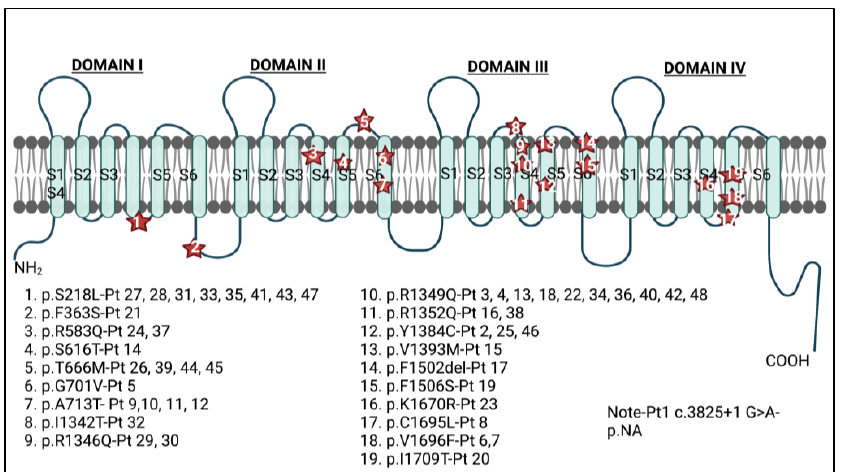
Figure 3. Schematic illustration of the Ca v 2.1 alpha1A subunit with the de novo pathogenic variants associated with SHM1 identified in this systematic review. Variants were aligned to RefSeq transcript NM_001127221.1. The image shown is the full protein sequence including all exons. The variant in patient 18 was corrected due to a reporting error in the original paper. Created with BioRen- der.com.